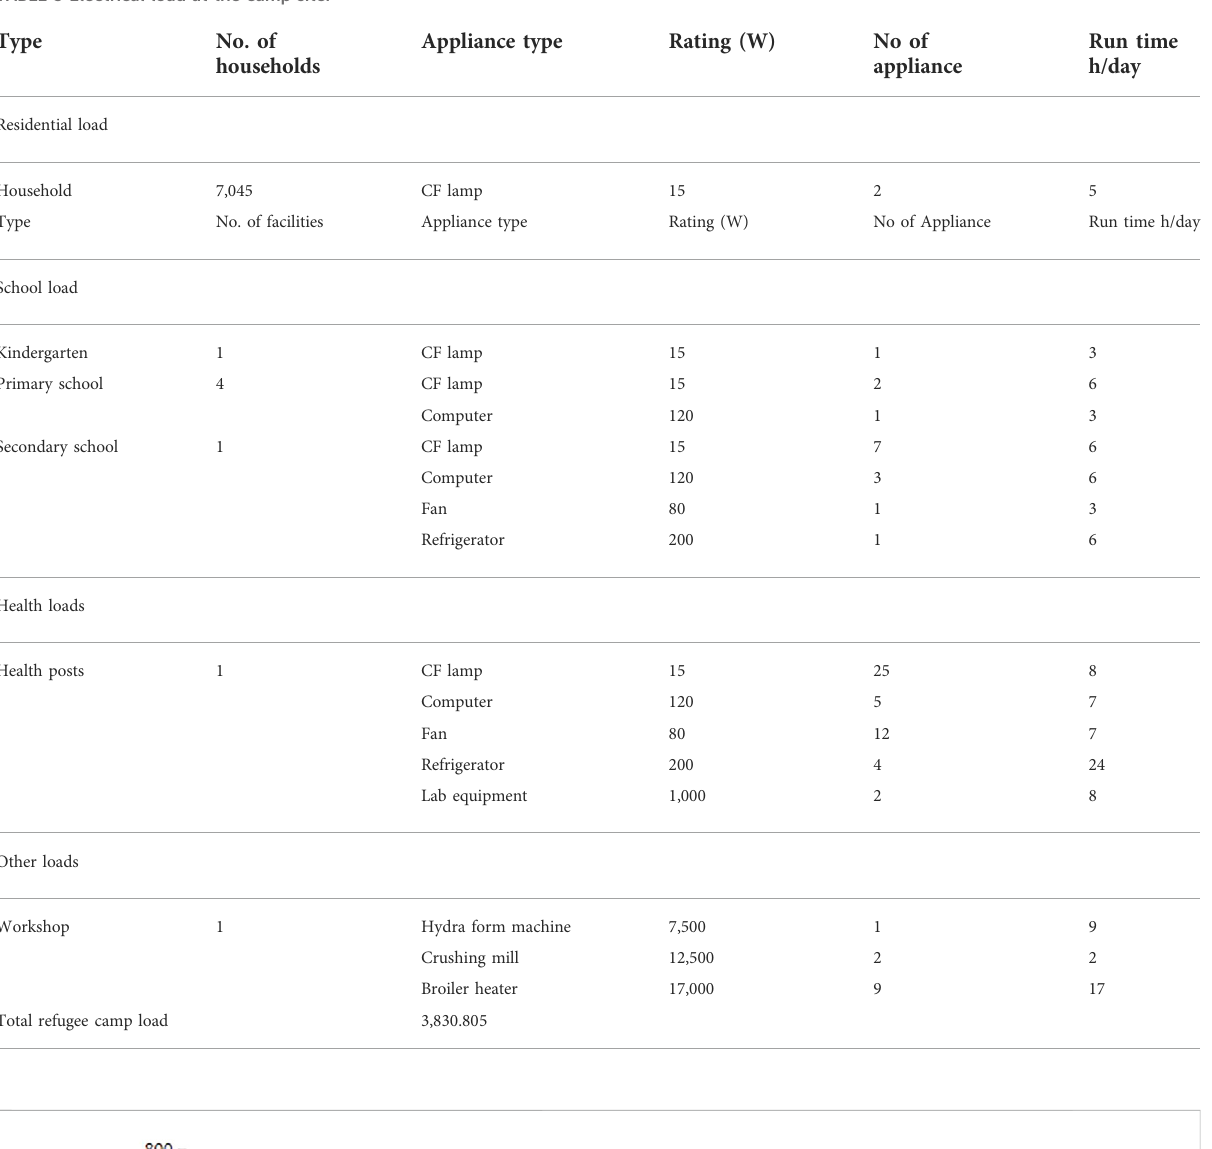
TABLE 3 Electrical load at the camp site.